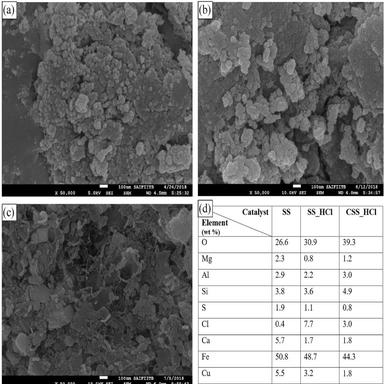
Scanning electron microscopy images (magnification ¼ 50000) of a) SS, b) SS_HCl, c) CSS_HCl and d) elemental composition determined using EDS analysis.